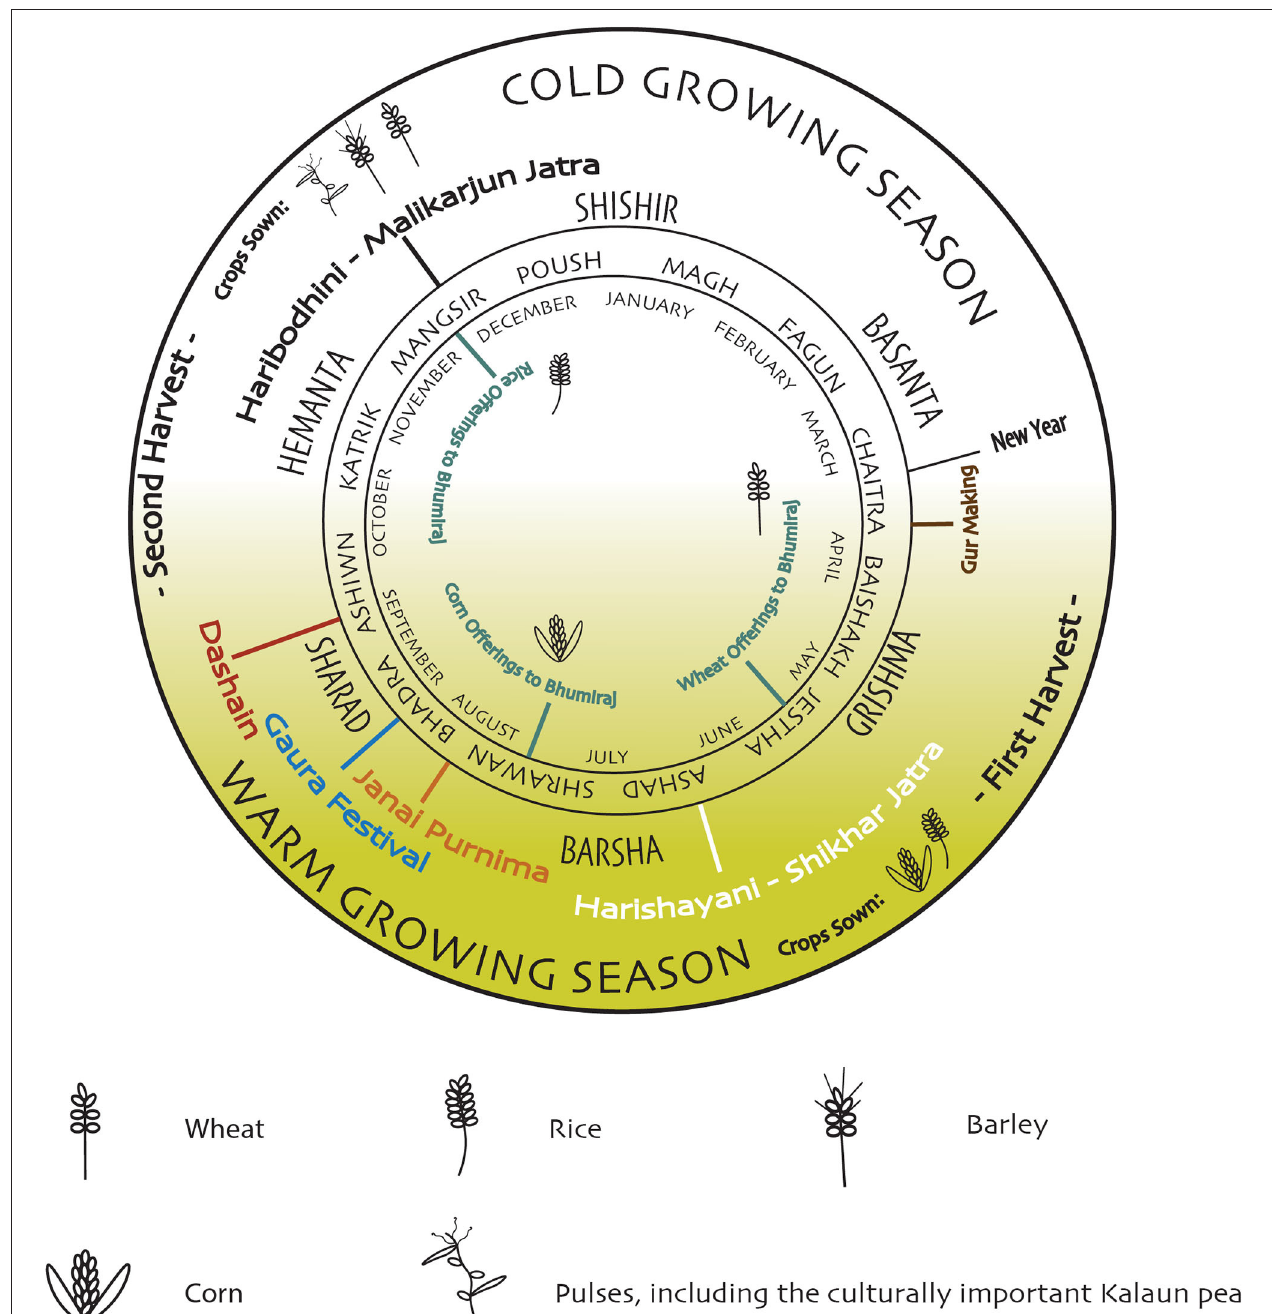
FIGURE 2 | A representation of the ritual and agricultural calendar of Malikarjun, showing Nepali months and seasons alongside Gregorian months. Two agricultural seasons corresponding to the two main sowing and harvest times are visible in white and yellow, respectively. The most important crops are also indicated, namely wheat, corn, rice, barley, and pulses including the culturally important kalaun pea. The timing of the harvest offerings to the land deity Bhumiraj are indicated in the center. Key festivals are marked alongside the Hindu cosmic cycle of Haribodhini and Harishayani.